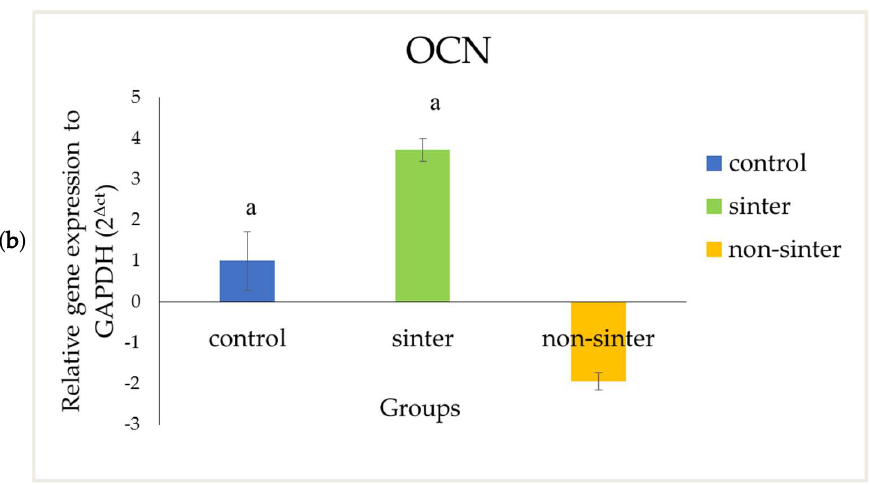
Figure 6. Relative expression of osteoblast markers (a) Colα1 and (b) osteocalcin (OCN) for cells seeded on sinter and nonsinter hydroxyapatite scaffolds, and the control group. Same letter of a, b denotes significant differences within group ( p > 0.05).